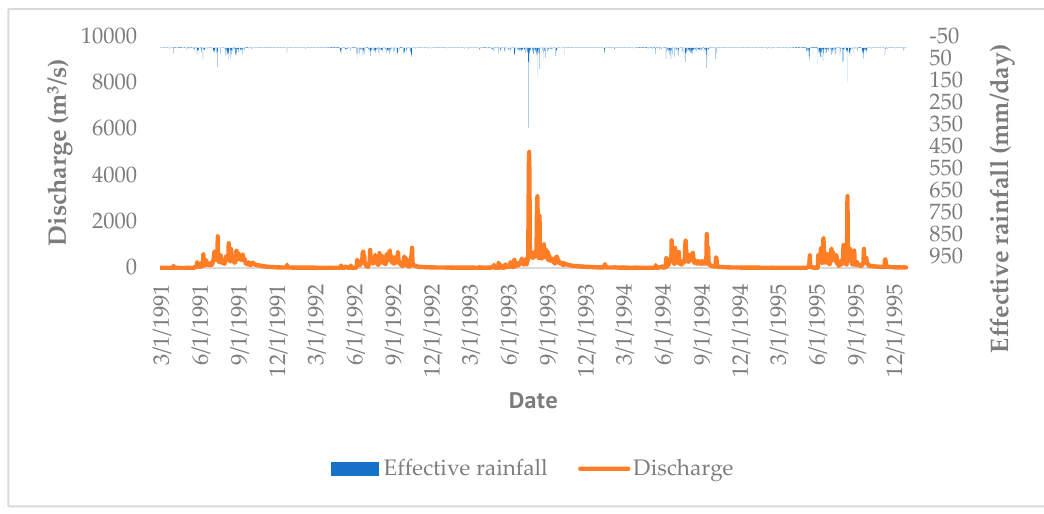
Figure 3. Hydrograph of the Bagmati Catchment from 1 March 1991 to 31 December 1995.